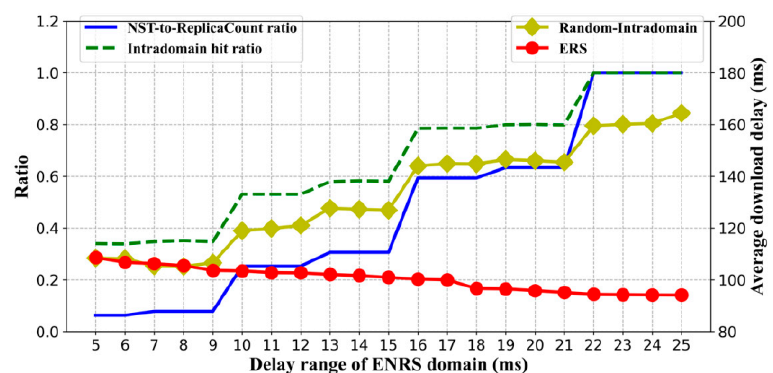
Figure 10. Performance and overhead under different delay ranges of ENRS domain.